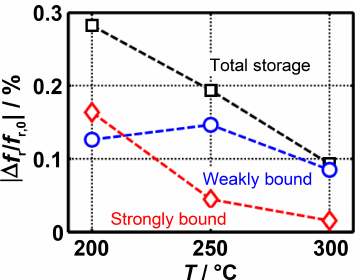
Figure 5. Frequency shift caused by strongly and weakly bound ammonia at different sensor temperatures.